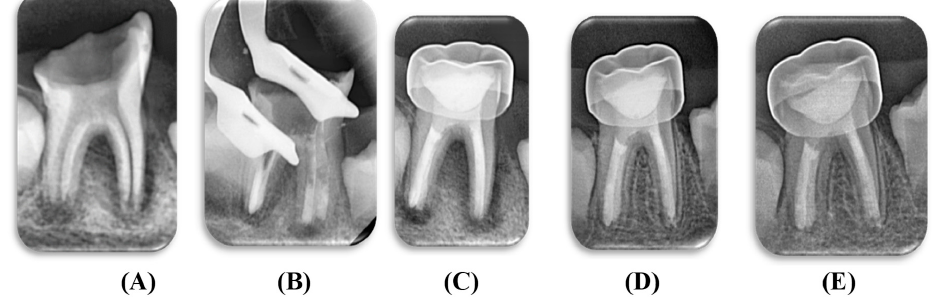
Figure 4. Apexification using MTA as an apical plug: ( A ) preoperative; ( B ) after placement of the apical plug; ( C ) postoperative; ( D ) 6 months follow-up; ( E ) 12 months follow-up.